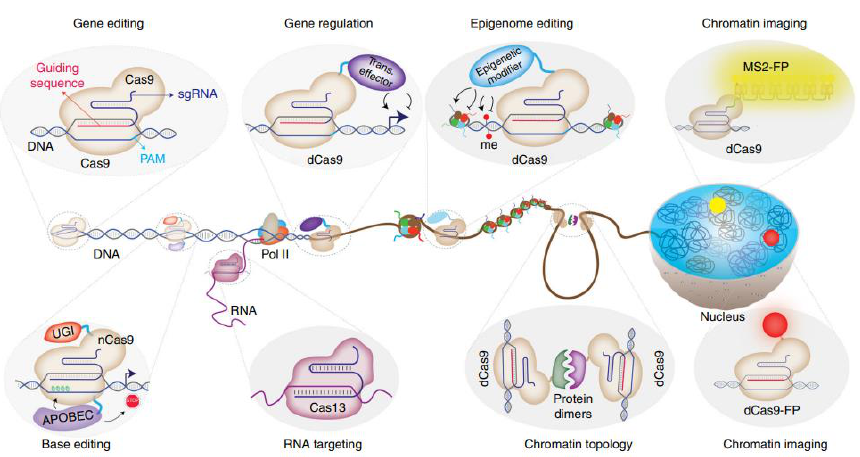
Figure 5. CRISPR technology: Beyond genome editing. Major application areas of CRISPR-Cas-based technologies beyond genome editing. While WT Cas9 enables genome editing through its guidable DNA cleavage activity, catalytically impaired Cas9 enzymes are repurposed to achieve targeted gene regulation, epigenome editing, chromatin imaging, and chromatin topology manipulations. Furthermore, the catalytically impaired nickase Cas9 enzyme is used as a platform for base editing without double-strand breaks. In addition to DNA-targeting Cas proteins, novel RNA-targeting CRISPR/Cas systems have been described as well. Reprinted with permission from ref. [40]. Copyright 2018, The Author(s). This method is known as clustered regularly interspaced short palindromic